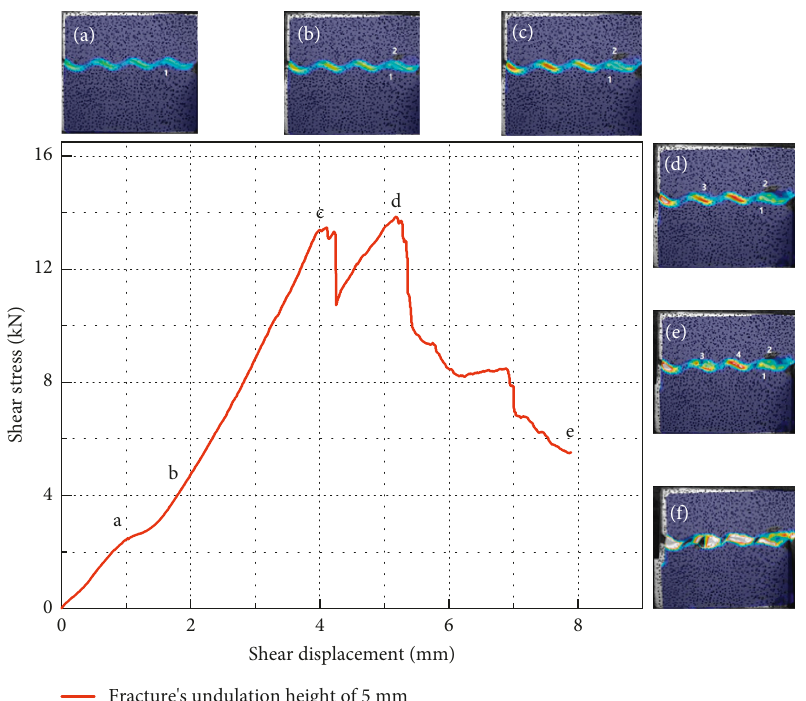
Figure 4: Shear stress-shear displacement curve of the specimen with an undulated height of 5